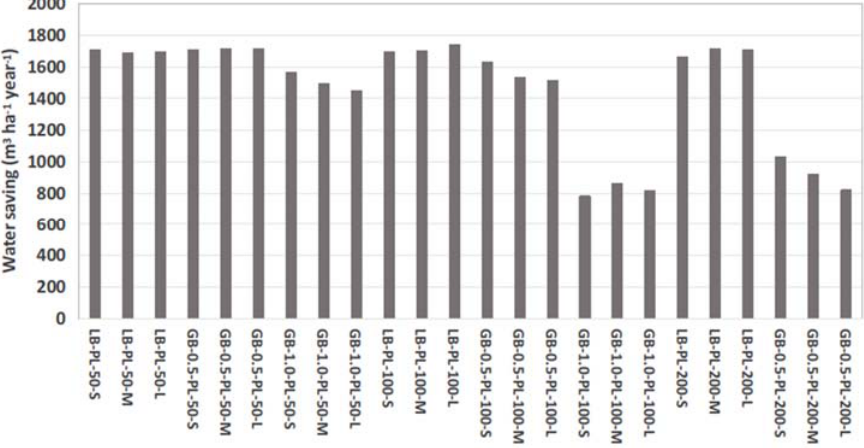
Figure 6. Water saving achievable by various design alternatives for level basins (LB) and graded basins (GB) with slopes of 1.0‰ and 0.5‰, with precise land levelling (PL); lengths of 50, 100, and 200 m; and inflow rates S, M, and L (as defined in Table 7) for a medium infiltration soil.